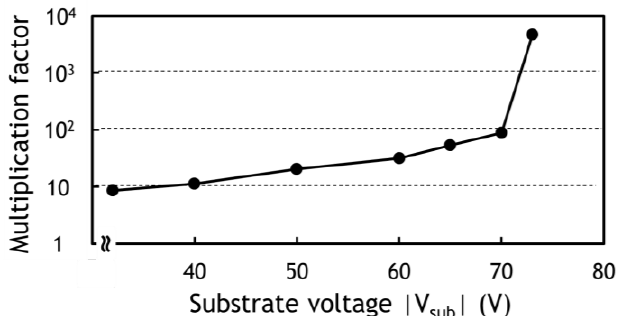
Figure 10. Multiplication factor of VAPD as a function of applied substrate voltage, V sub . It is noted that V sub is actually negative since the substrate is p-type and the bias is reversed.